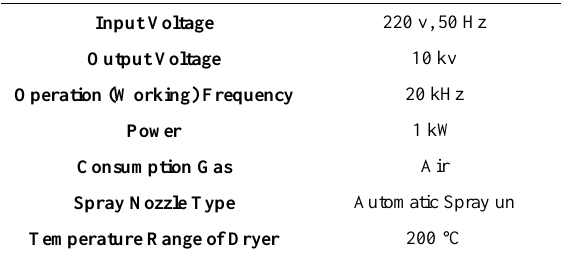
Table 1. Treatment Parameters of Fe 2 O 3 Thin Film by Cold Plasma